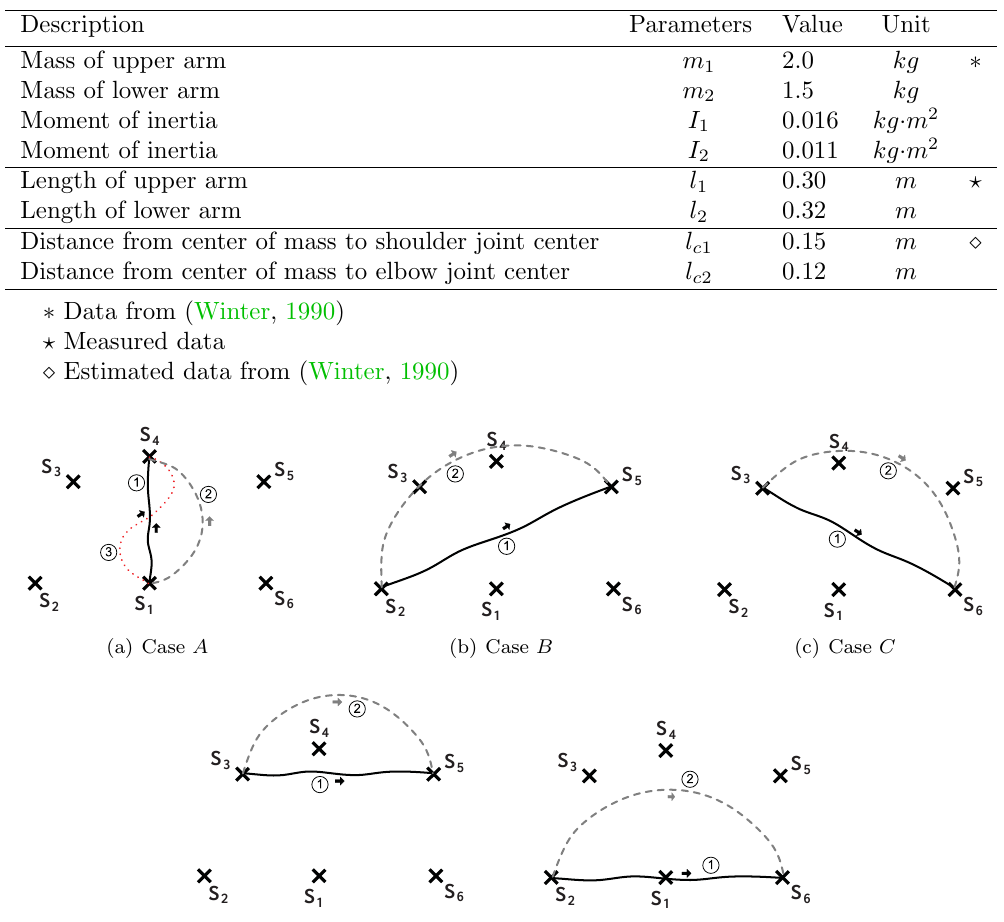
Table 1: Parameters of a human arm.